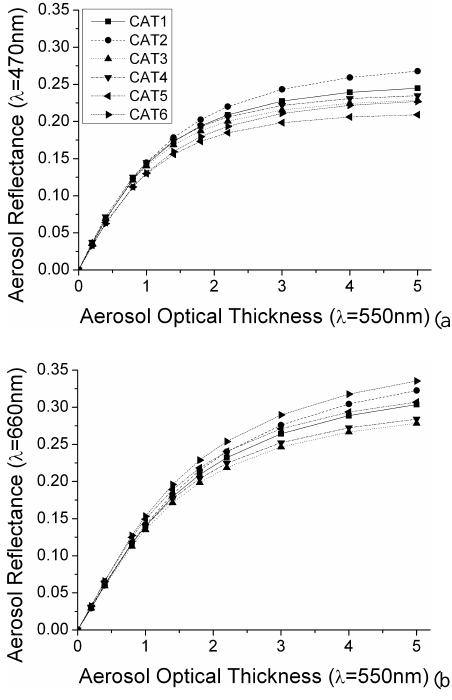
Fig. 6. Aerosol reflectance – (a) λ =470 and (b) 660nm – as a function of AOT at 550nm, obtained by SBDART calculations with aerosol models from this study (geometrical inputs are θ 0 =60 ◦ , θ S =30 ◦ , and ϕ =0 ◦ ). These plots show the increase in aerosol re- flectance for different aerosol models with AOT.